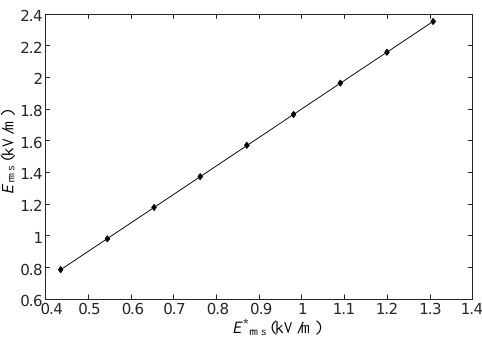
Figure 8. Relation curve of the electric field intensity at P before and after the approach of a human body.